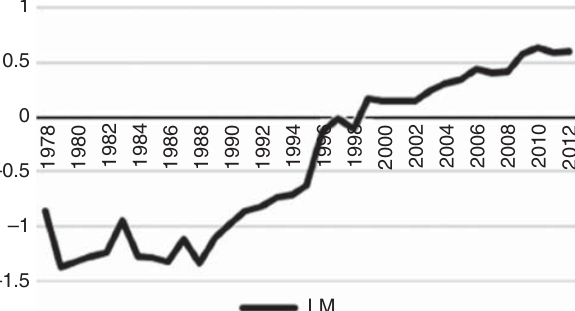
Figure 5. Logarithm of per capita maritime transportation volume